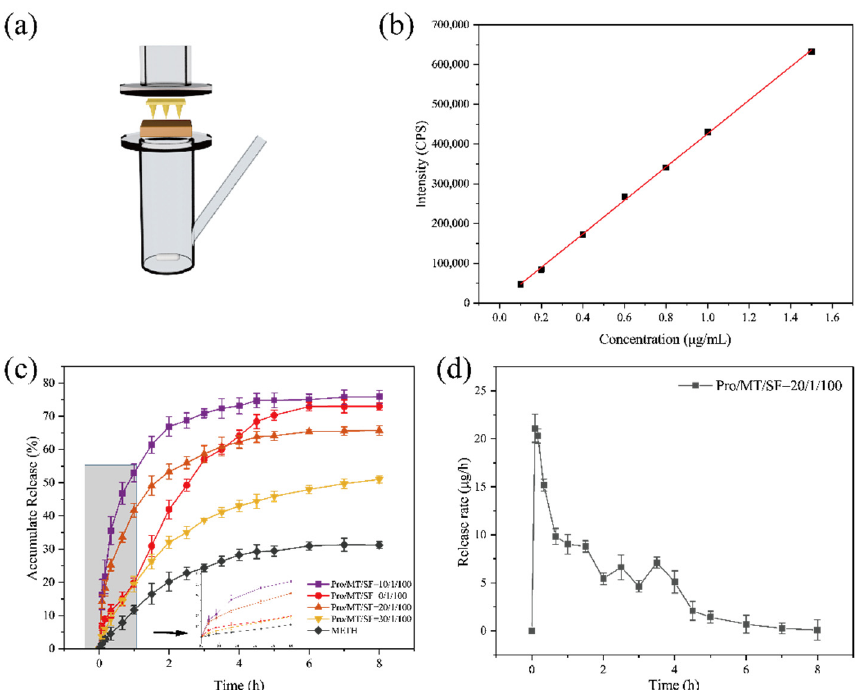
Figure 9. In vitro drug release of MT/SF@MNs: ( a ) in vitro drug-release setup, ( b ) standard curve of melatonin fluorescence detection, ( c ) cumulative release curve of MT/SF@MNs, ( d ) release rate curve of Pro/MT/SF = 20/1/100 MNs, and ( c , d ) were tested by Horiba FluorOMAX-4 fluorescence spectrometer.